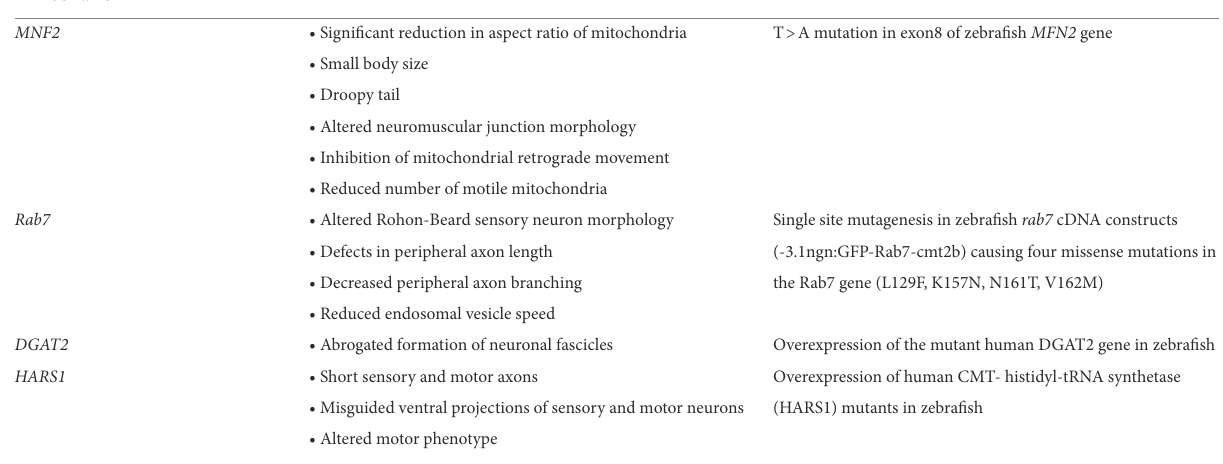
TABLE 2 Zebrafish CMT models and their distinct